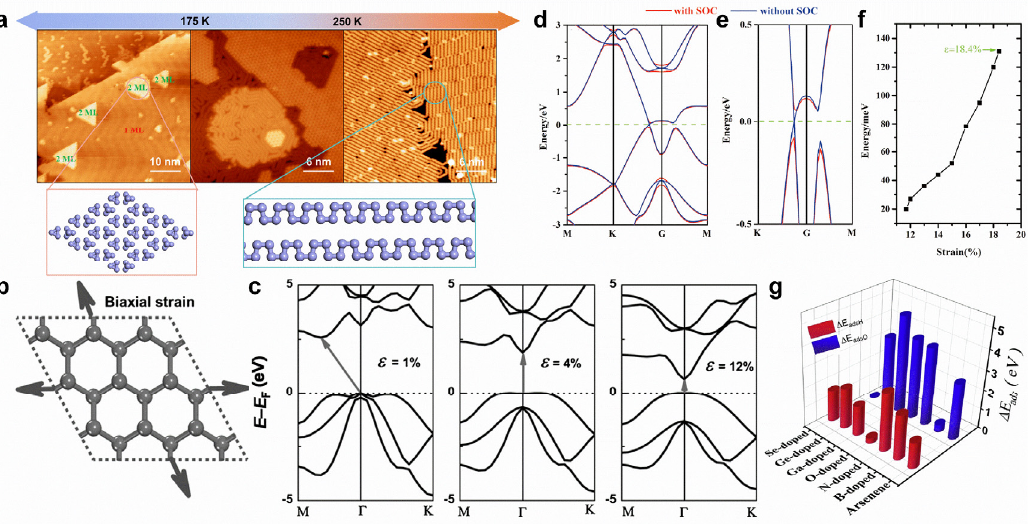
Figure 11. Surface modifications of arsenene. ( a ) Schematic diagram of substrate‑temperature‑ dependent arsenic nanostructures on Au(111) substrate. ( b ) Schematic representation of arsenene under biaxial tensile strain. ( c ) Variations in electronic band structures of arsenene under various biaxial strains. The arrows represent the transitions of the bandgaps. ( d , e ) Band structure of ar‑ senene under a biaxial tensile strain of 18.4% and an enlarged view. ( f ) Bandgap variation in ar‑ senene with the tensile strain. ( g ) Adsorption energy of hydrogen and oxygen on pristine and B‑, N‑, O‑, Ga‑, Ge‑, and Se‑doped arsenene. ( a ) Reprinted with permission from Ref. [32]. Copyright 2022, American Chemical Society. ( b , c ) Reprinted with permission from Ref. [24]. Copyright 2015, Wiley. ( d – f ) Reprinted with permission from Ref. [177]. Copyright 2015, Royal Society of Chemistry. ( g ) Reprinted with permission from Ref. [181]. Copyright 2018, Elsevier